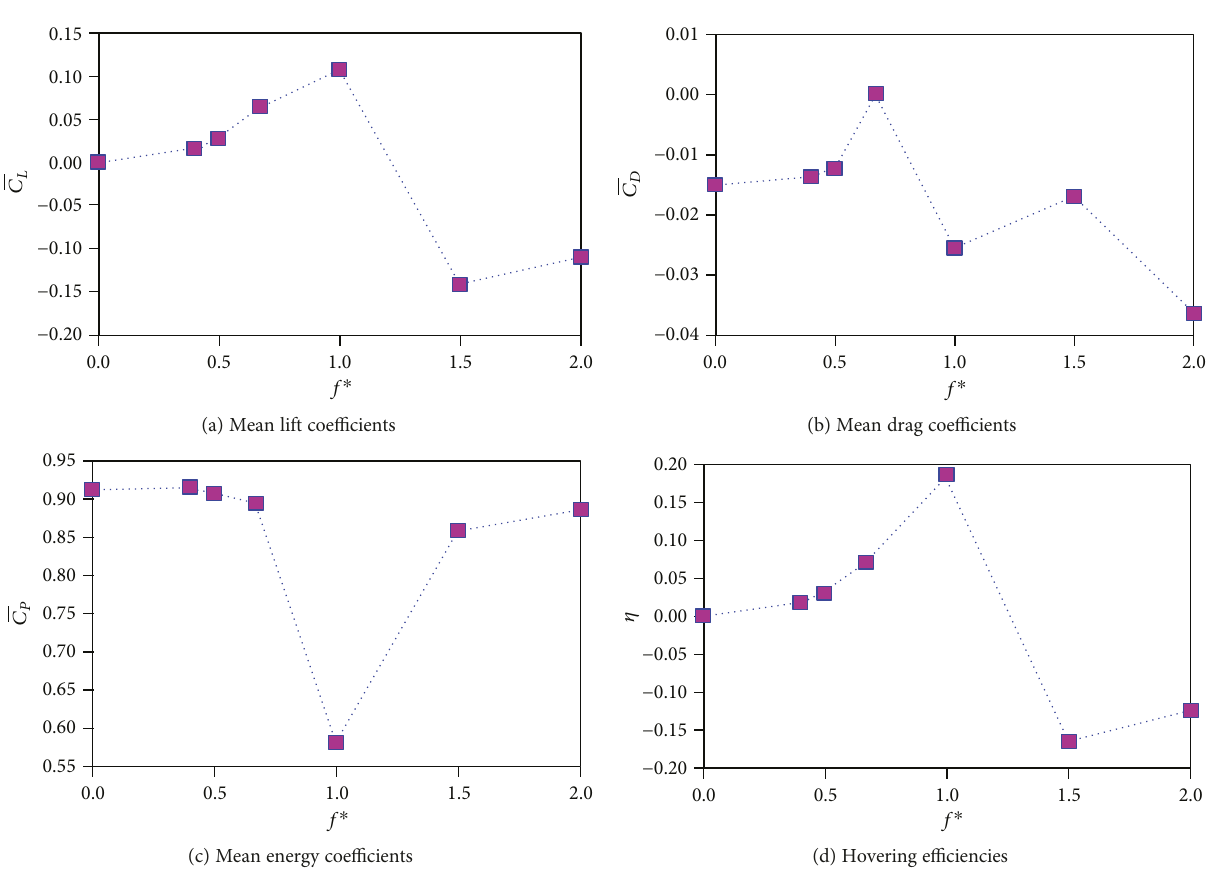
Figure 7: The performance of the 3D lumped fl exibility wing with di ff erent f ∗